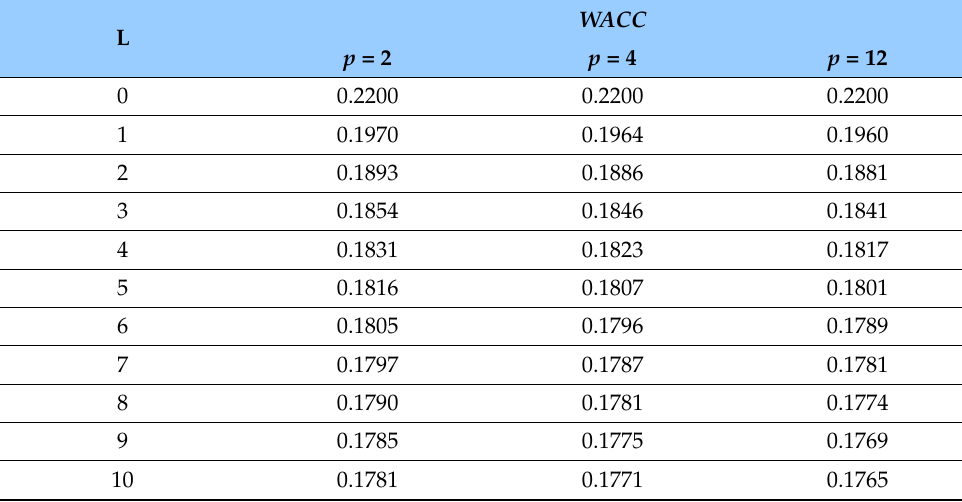
Table A2. Dependence of WACC on leverage level L at k 0 = 0.22 and different p = 2; 4; 12.